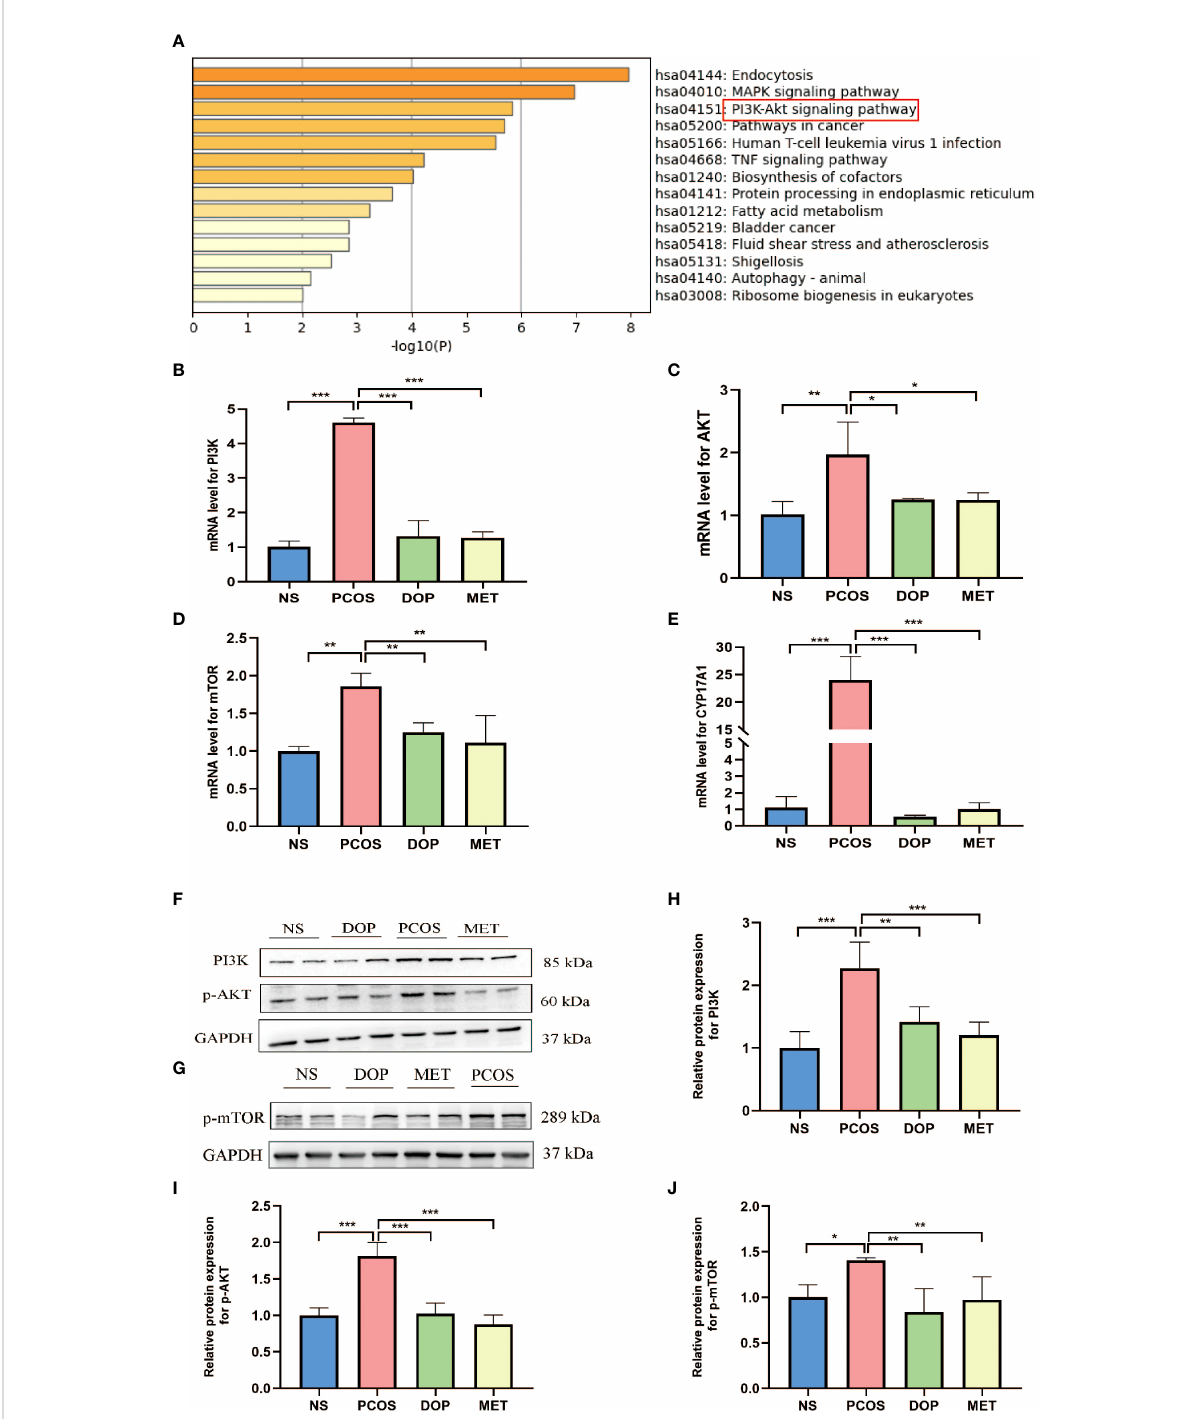
FIGURE 5 Effects of DOP treatment on the PI3K – Akt – mTOR signaling pathway in rats by qPCR and Western blot. (A) Top 14 clusters from Metascape pathway enrichment analysis differently expressed associated genes. Signi fi cance is indicated by the − log10 (P) value. (B – E) Ovarian gene PI3K, Akt, mTOR, and CYP17A1 expression levels, n = 3. (F – J) Expressions of PI3K, p-Akt, and p-mTOR protein are expressed as the fold change in the optical density of a target protein, and GAPDH expression served as the control, n = 2. Note: compared with the PCOS group, * p < 0.05, ** p < 0.01, *** p <